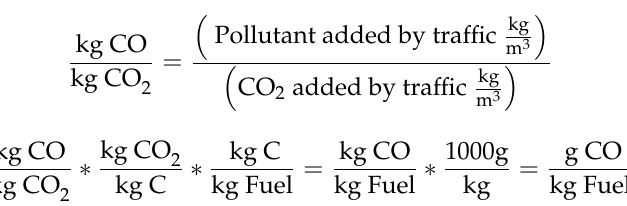
Figure 4. ( a ) Daily average PM2.5 concentrations measured in the garage by the MAAQSBox and ambient levels measured at the nearest AMS and ( b ) daily variation of PM2.5 and LDSA concentration and exit traffic, weekday 30 min averages.